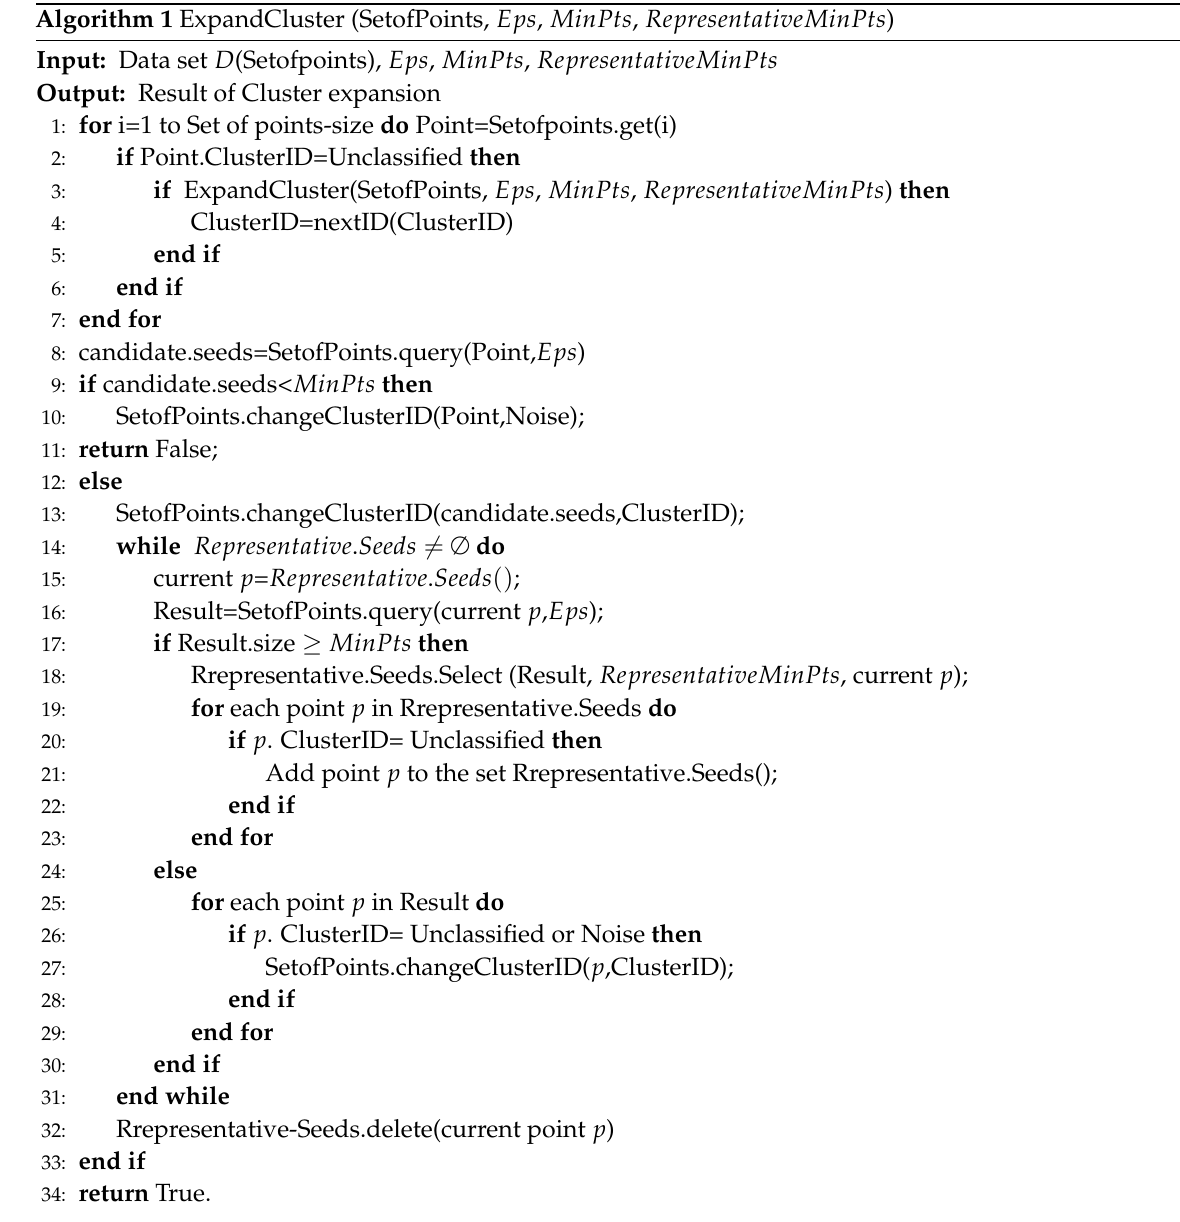
Algorithm 1 ExpandCluster (SetofPoints, Eps , MinPts , RepresentativeMinPts